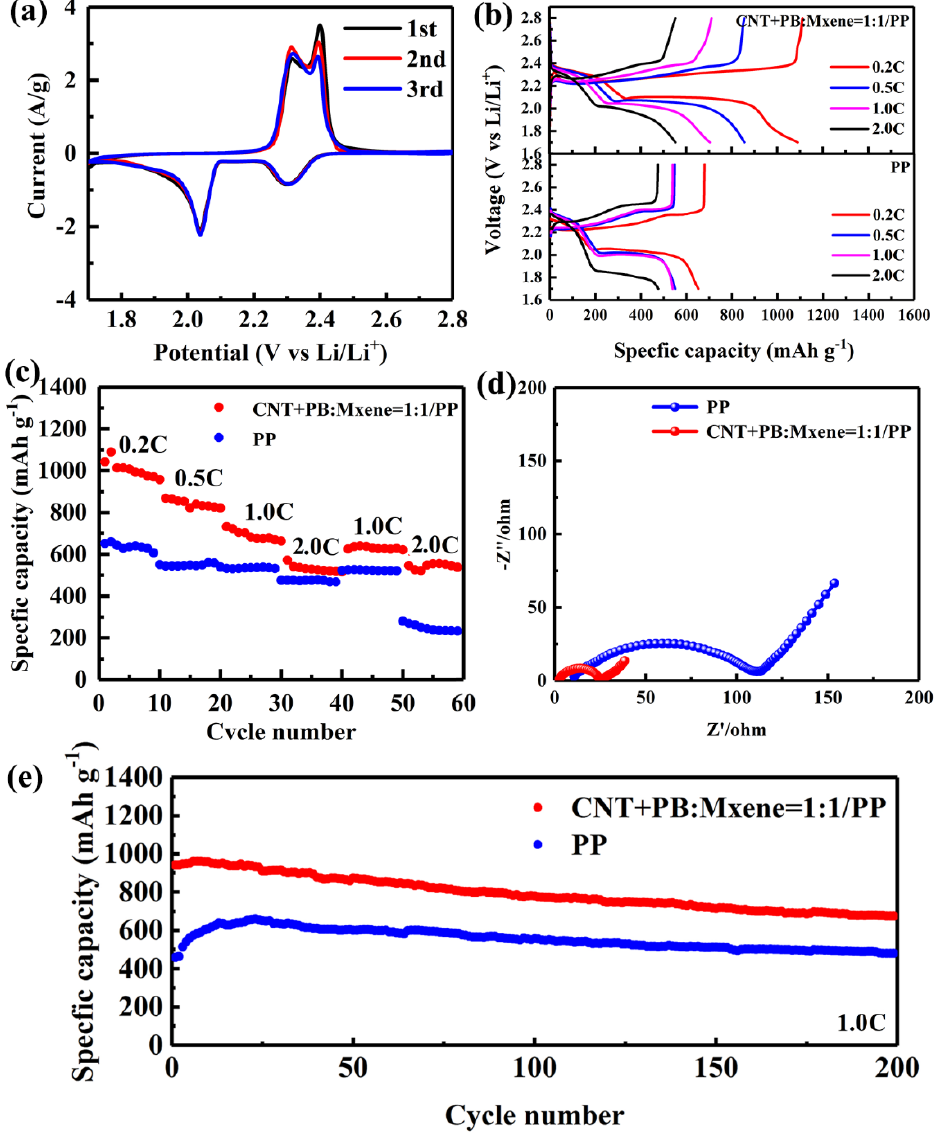
Figure 4. CV curves ( a ) at a scan rate of 0.1 mV s − 1 of LSB with the CNT+PB@MXene separator. Galvanostatic charge-discharge profiles ( b ) and rate performance ( c ) with CNT+PB@MXene/PP (above) and PP (below) separators at various C-rates from 0.2 C to 2.0 C. EIS profiles ( d ) and long-term cycling curves ( e ) with CNT+PB@Mxene/PP and PP separators.